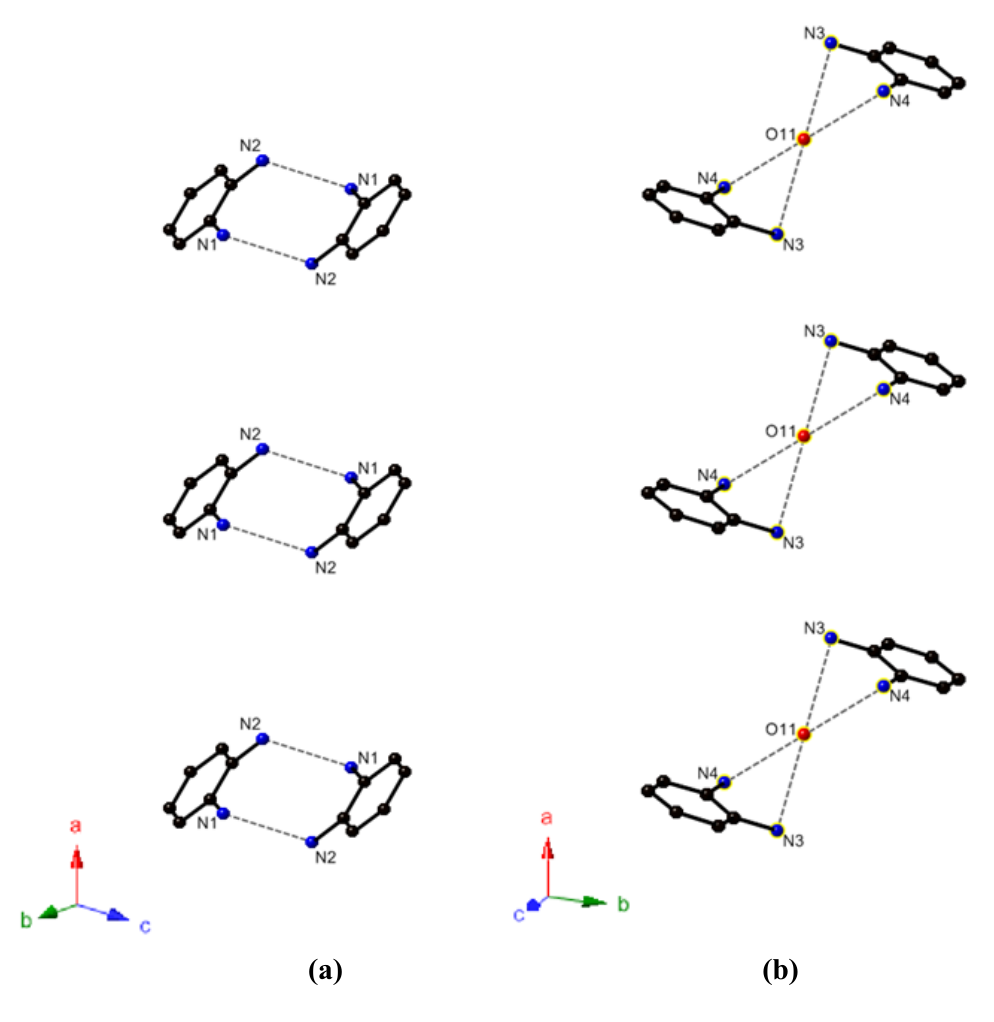
Figure 3. Crystal structure of 1 focusing on the o -(H atoms are omitted for clarity. Short contacts are indicated by gray dashed lines. (black, C; blue, N) (a) o -(H water